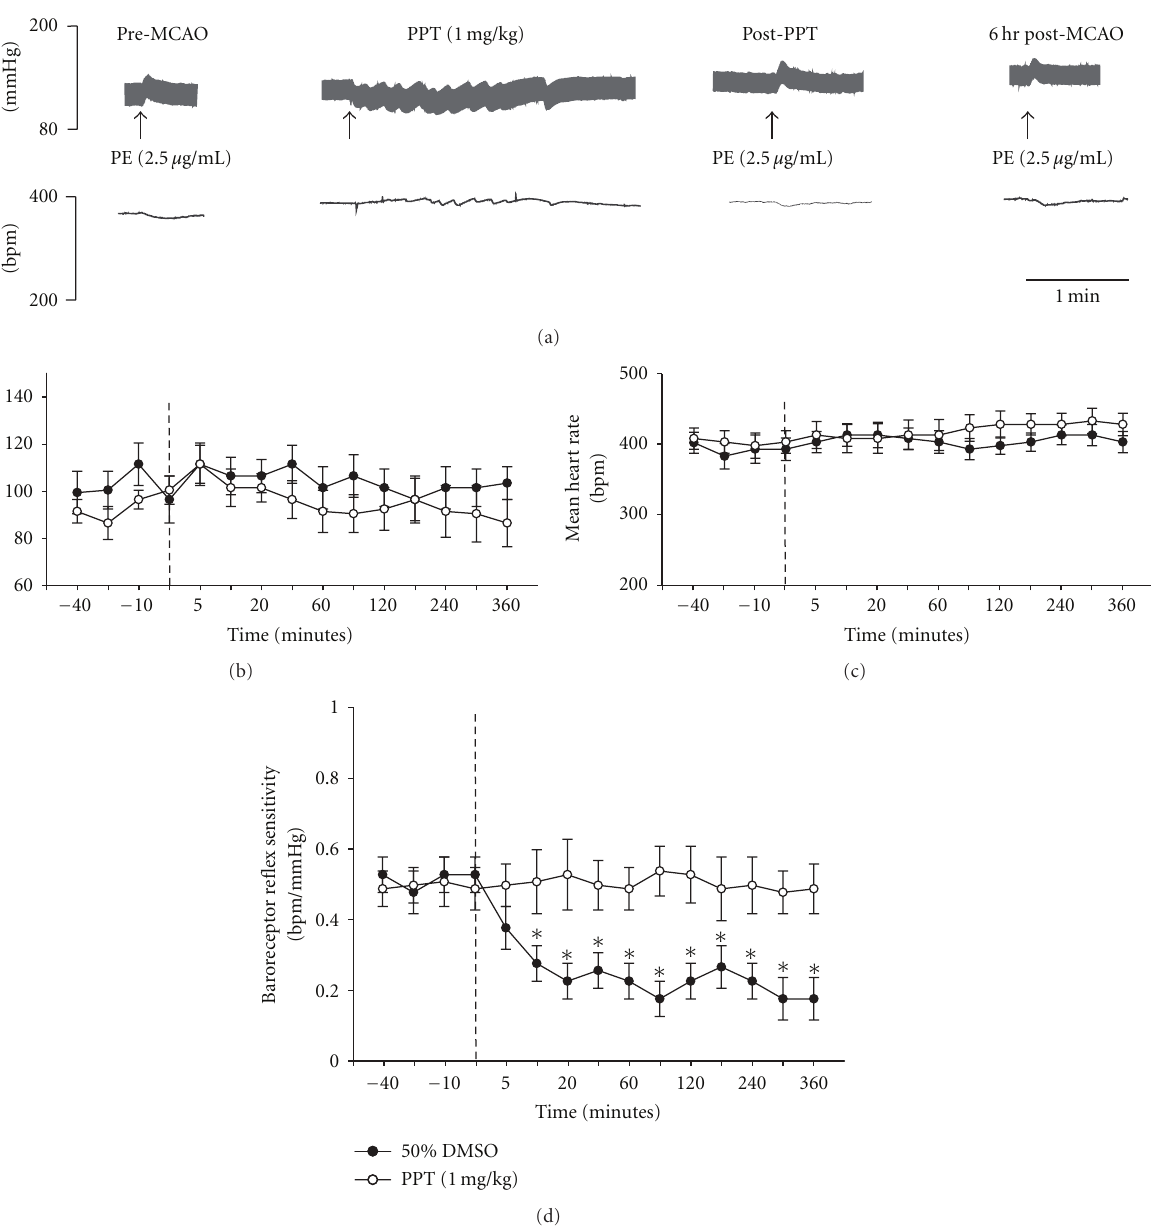
Figure 3: Cardiovascular responses to PPT (1mg/kg) or 50% DMSO pretreatment (i.v.; 30 minutes) prior to MCAO. (a) Representative physiograph tracings of changes in arterial pressure and heart rate to phenylephrine injection (PE; 2.5 μ g/mL). Graphs represent average changes in mean arterial pressure (MAP; (b)), heart rate (HR; (c)), and baroreceptor reflex sensitivity (BRS; (d)). The dashed lines represents the times at which the MCA was occluded. Each data point represents the mean ± S.E.M ( n = 4–6/group), and ∗ indicates significance ( P ≤ . 05) from baseline